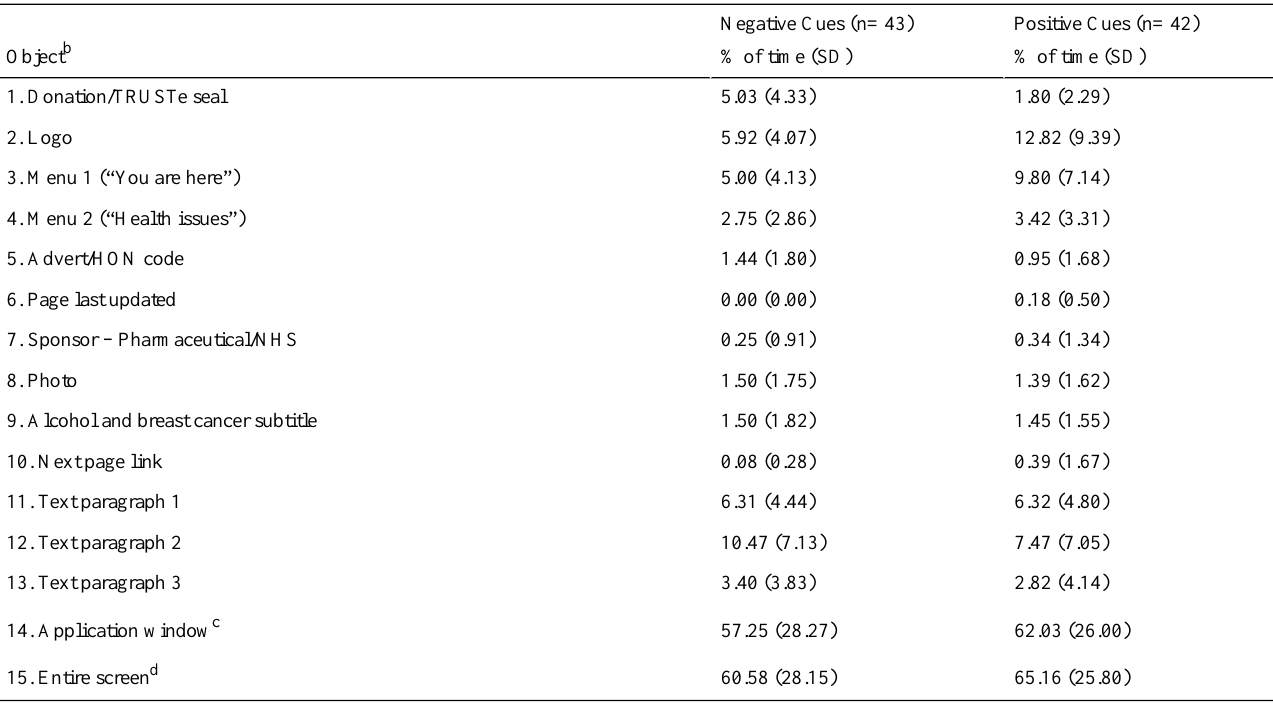
Table 2. Percentage of time participants spent visually examining objects on the website, by condition